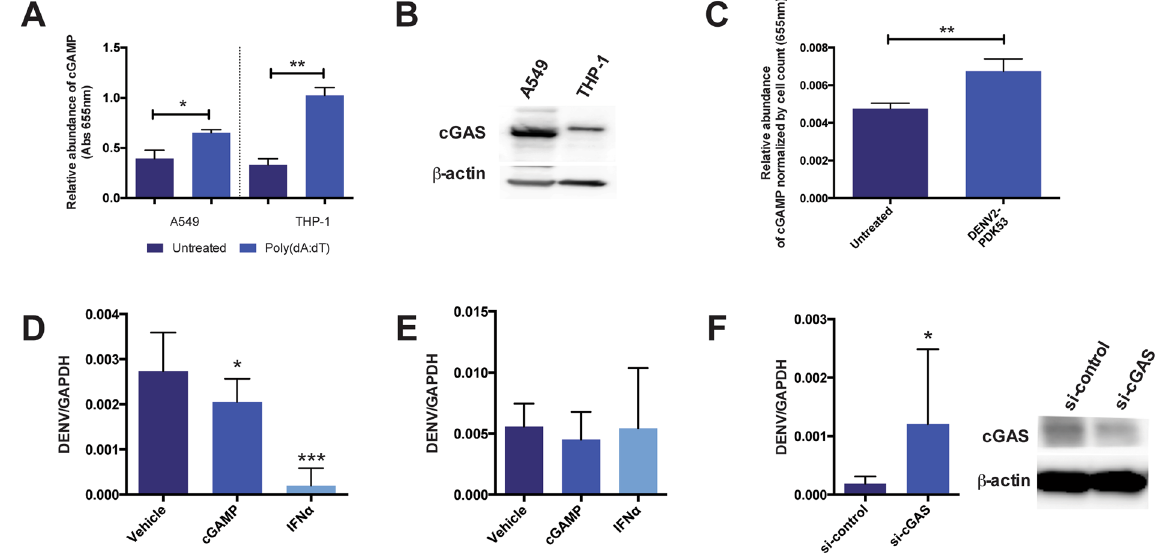
Figure 2. DENV infection activates cGAS-dependent antiviral responses. ( A ) In vitro assay for functional cGAS expression in A549 and THP-1 cell lysates as indicated by the production of cGAMP in the presence of 1 μ g/ml poly(dA:dT). Results demonstrate that cGAS is functional in A549 as it is in THP-1, as shown previously 3 . ( B ) Western blot analysis of cGAS expression in A549 and THP-1 cells (control). THP-1 cells used as positive control and not as point of comparison for cGAS expression levels between A549 and THP-1 cell lines. ( C ) cGAMP production in A549 cells that are uninfected or infected with DENV2-PDK53 at MOI 1 for 24 hrs. Absorbance values normalized by cell count of each group. Results shown are representative of at least three independent experiments. ( D , E ) DENV RNA levels in infected A549 cells that were pre-treated ( D ) or post-treated ( E ) with 1 μ g/ml cGAMP or 250 units/ml IFN α . Results are normalized by GAPDH expression and represent mean ± SD of at least four independent experiments. ( F ) DENV RNA levels in cGAS knockdown (si-cGAS) A549 cells compared to siRNA scrambled control (si-control) when infected with DENV2-PDK53 at MOI 1 for 24 hrs, assessed by RT-qPCR and normalized by GAPDH expression. Western blot confirmation of decreased cGAS expression in si-cGAS A549 cells, normalized with β -actin. Data is represented as mean ± SD of at least three independent experiments. In this figure, * depicts P < 0.05; ** depicts P < 0.01 and *** depicts P <